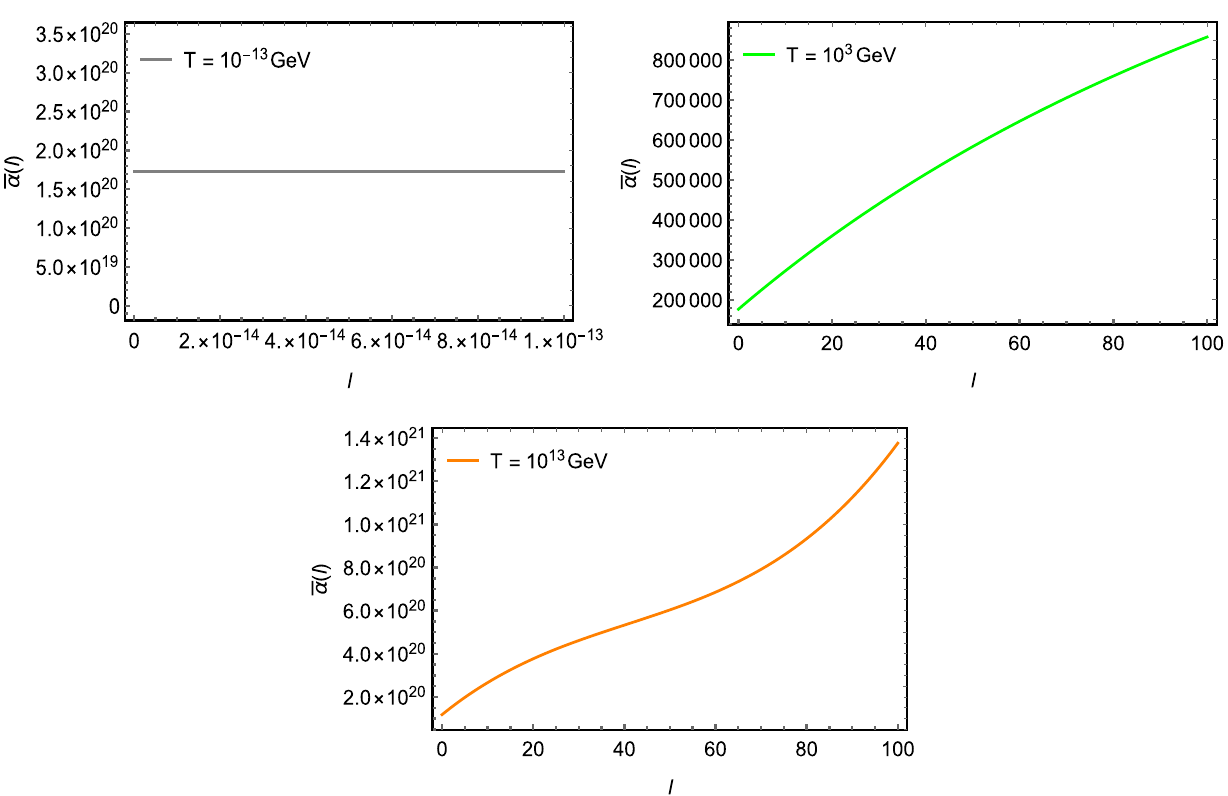
Fig. 9 The figure shows the correction to the Stefan–Boltzmann law represented by parameter ¯ α as a function of l ( whose dimension is m · kg − 1 / 2 · s − 1 ) considering the temperatures of cosmic microwave background (top left), electroweak scenario (top right), and the early inflationary universe